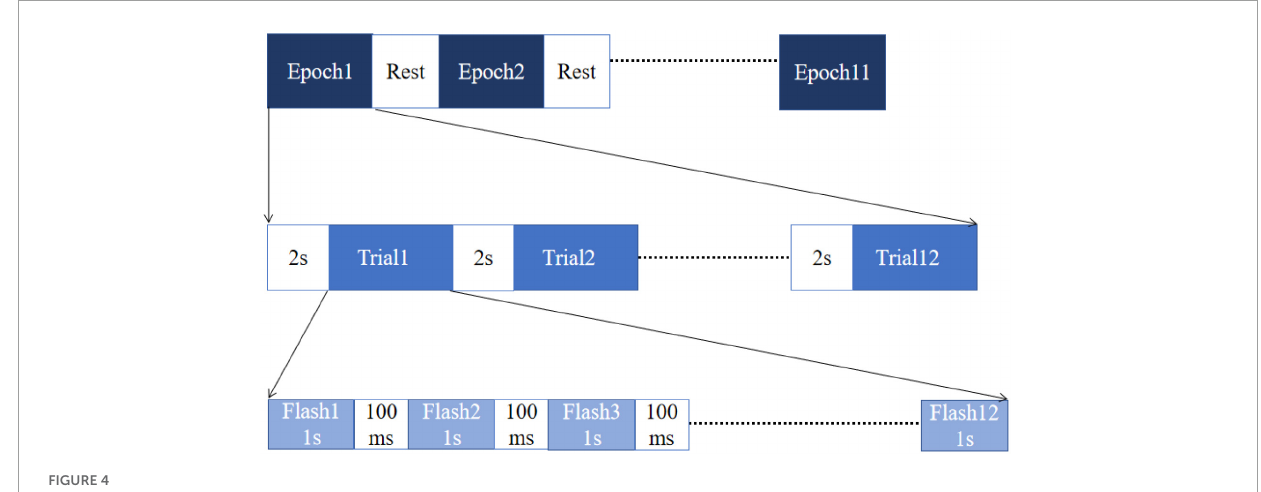
FIGURE4 The time sequence diagram of the offline